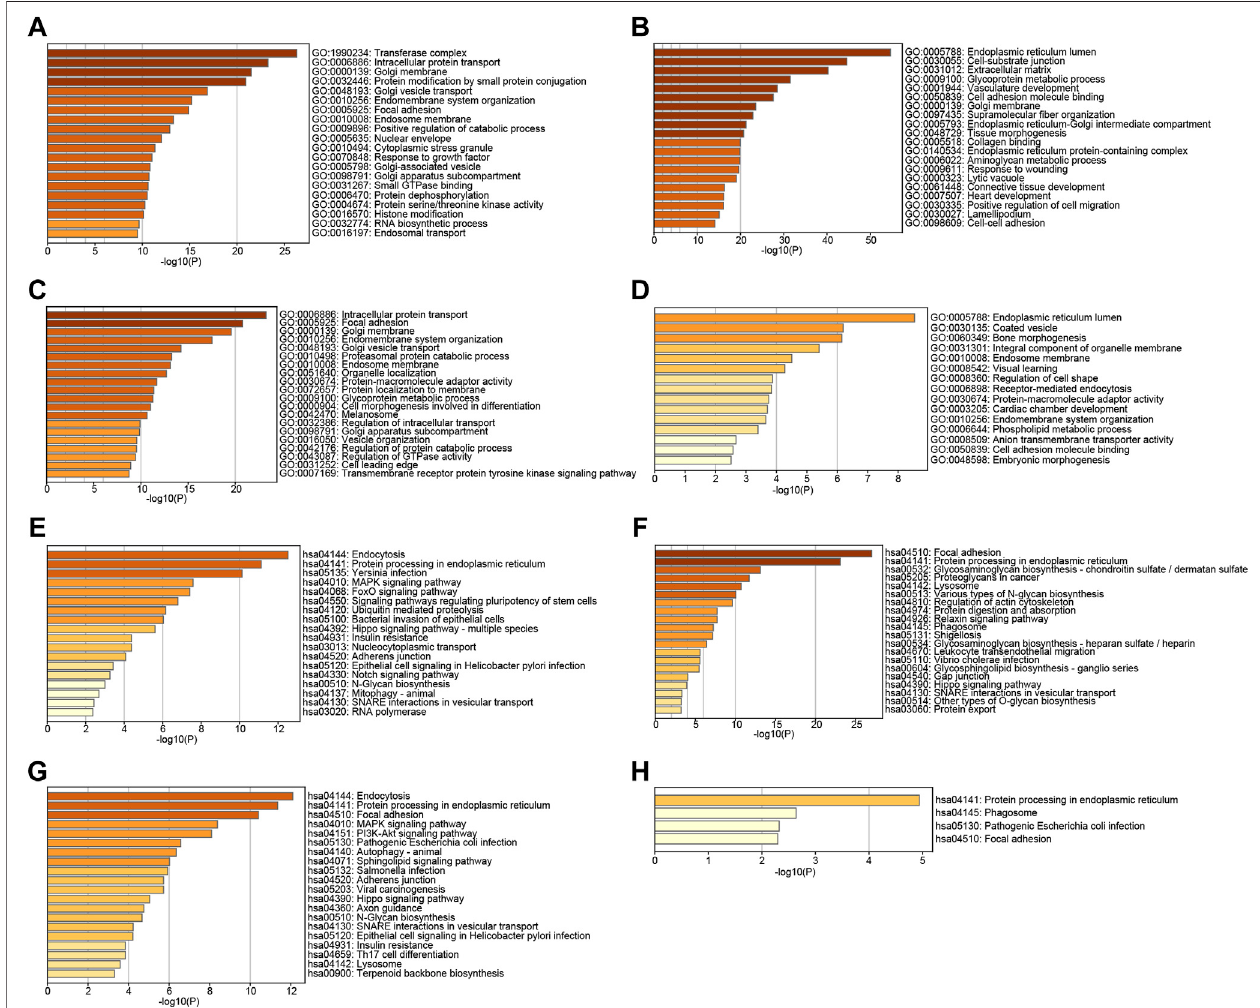
FIGURE6| GOanalysisof (A) TMED2, (B) TMED9, (C) TMED10and (D) co-expressiongenes.KEGGpathway enrichmentanalysisof (E) TMED2, (F) TMED9, (G) TMED10, and (H) co-expression genes.